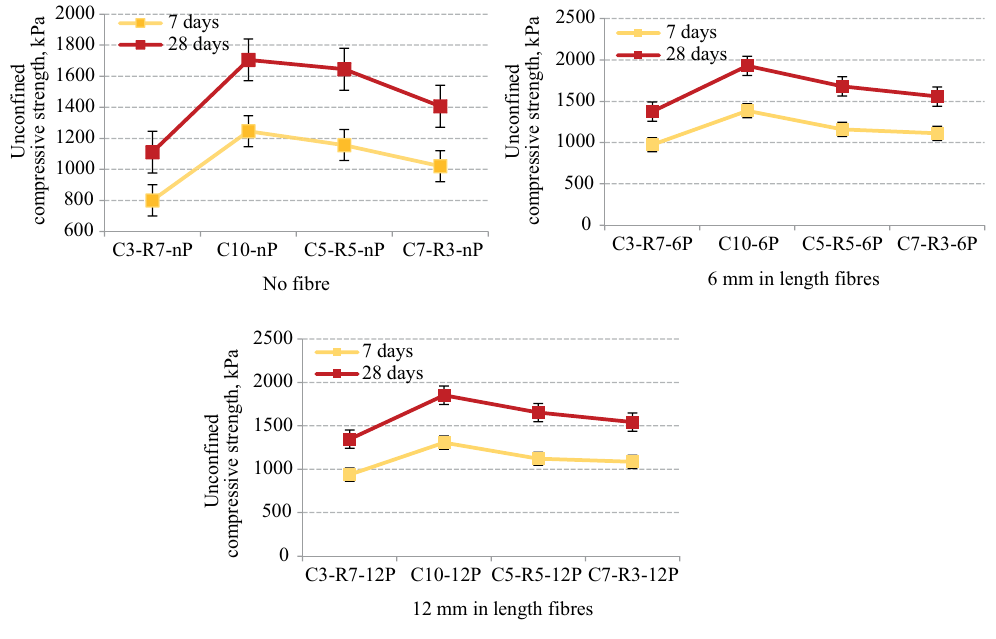
Figure 4. The unconfined compressive strength of samples containing 10% stabiliser and RHA/OPC ratios of 0:10, 3:7, 5:5 and